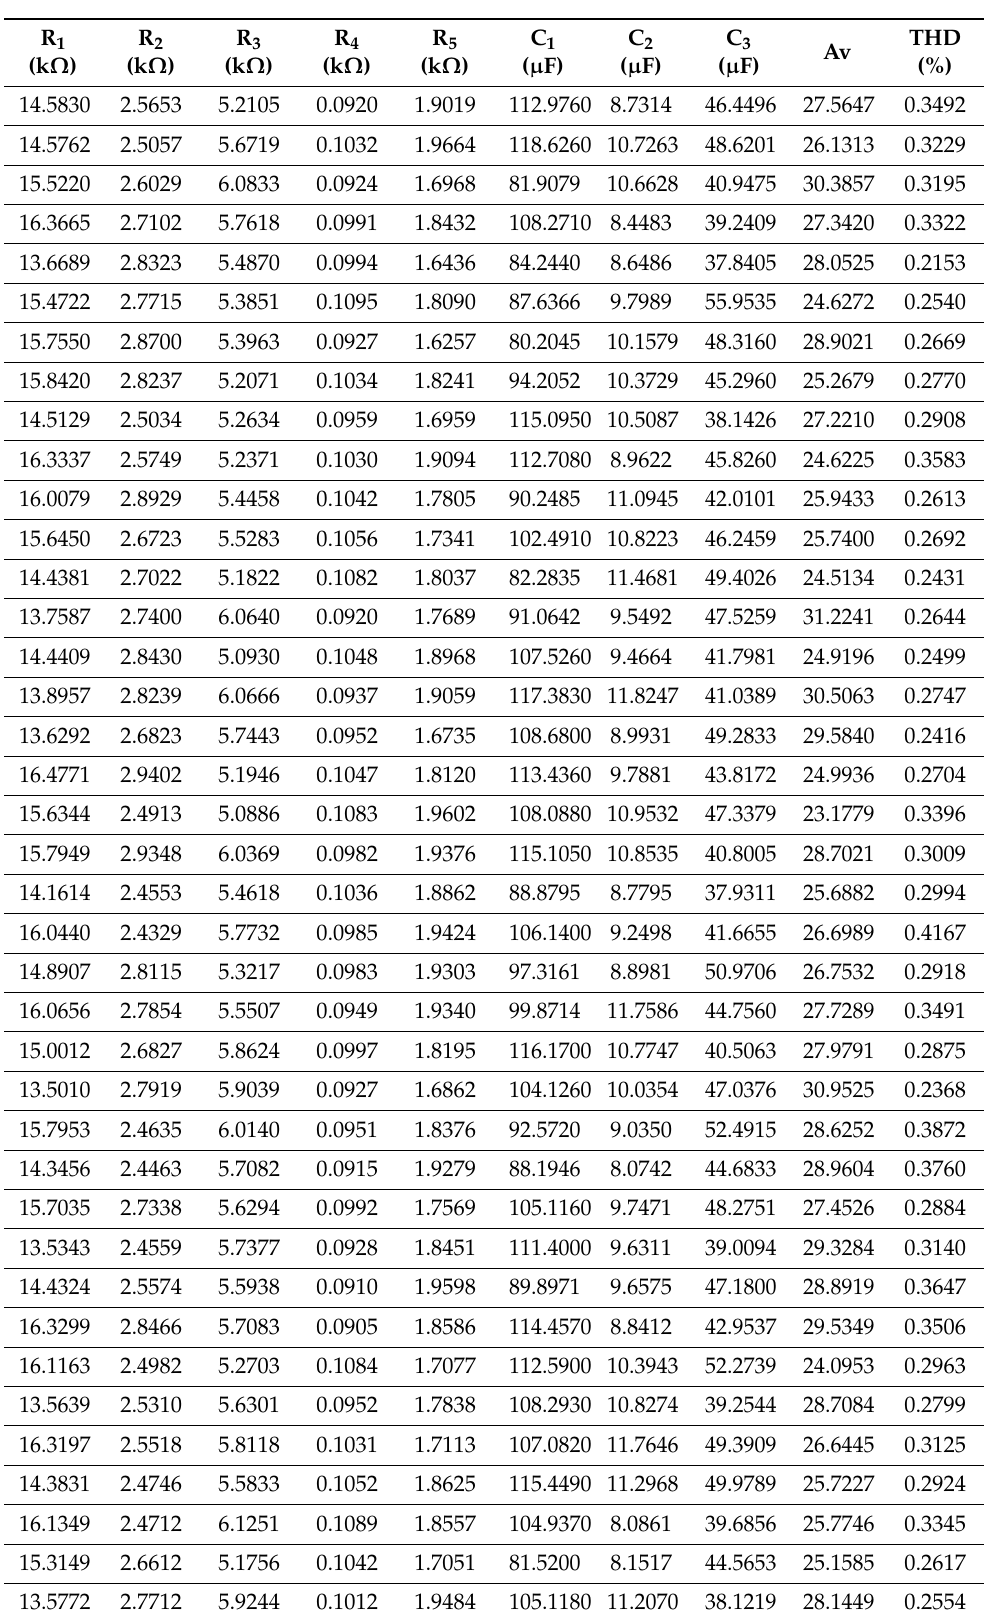
Table A2. Validation